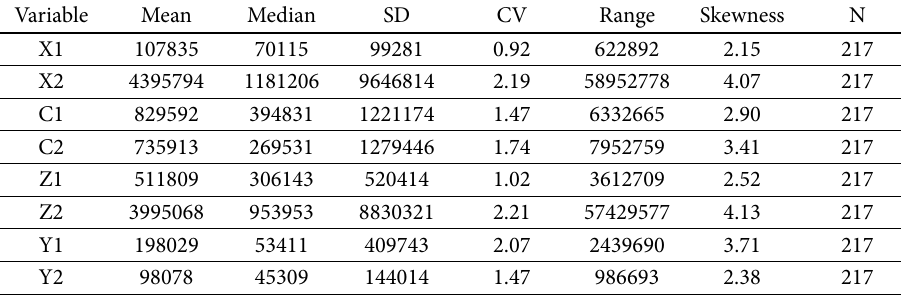
Table 3. Summary statistics of the input, carry-over, intermediate, and output variables Variable Mean